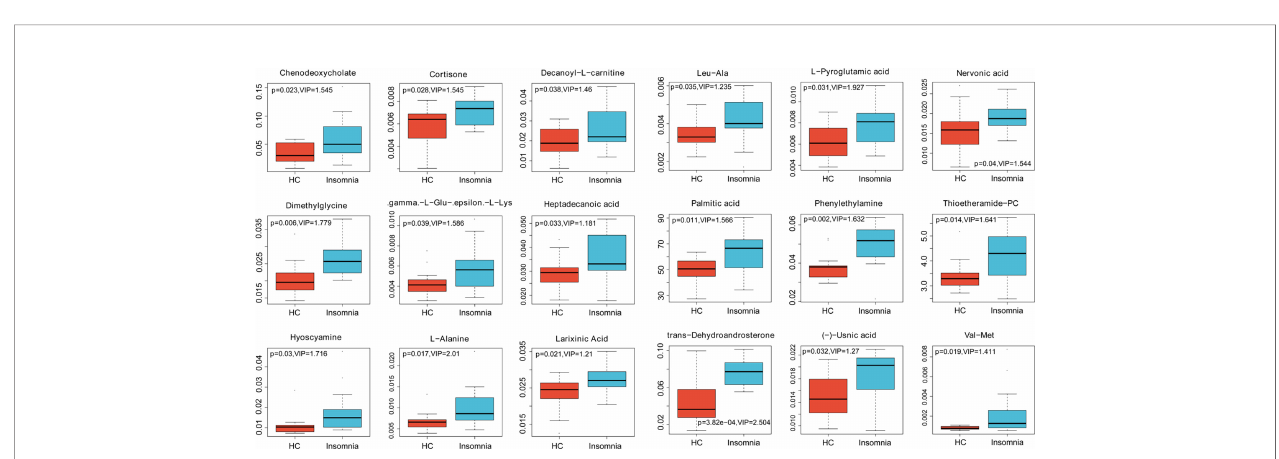
FIGURE 4 | Box plots (part II) of signi fi cantly changed metabolites identi fi ed in LC-MS analysis. Blue, patients with insomnia; Orange, healthy controls.